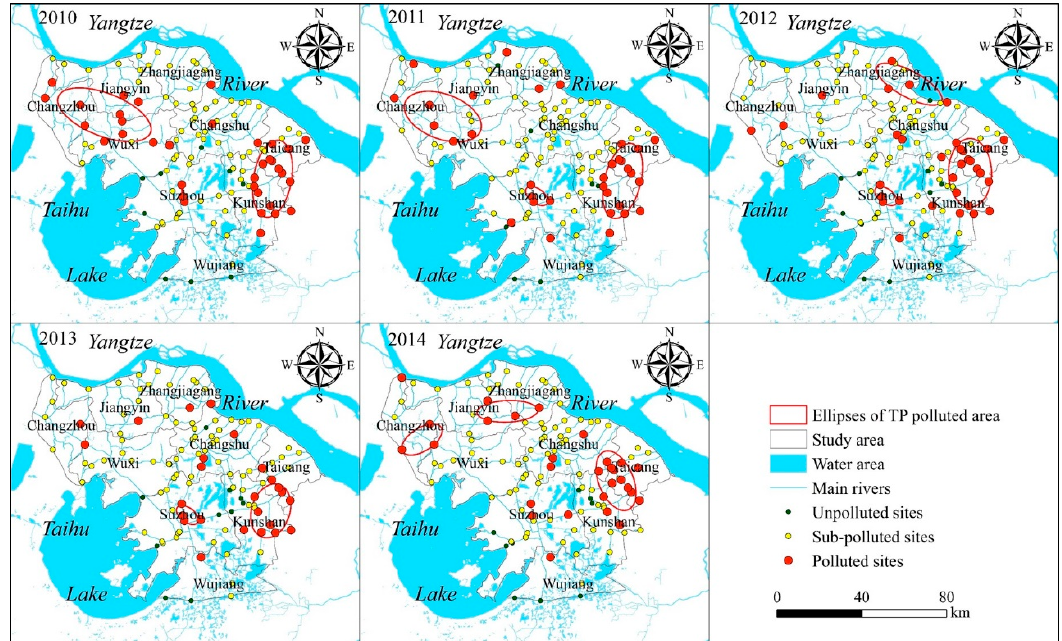
Figure 6. Standard ellipses of TP polluted regions from 2010 to 2014.